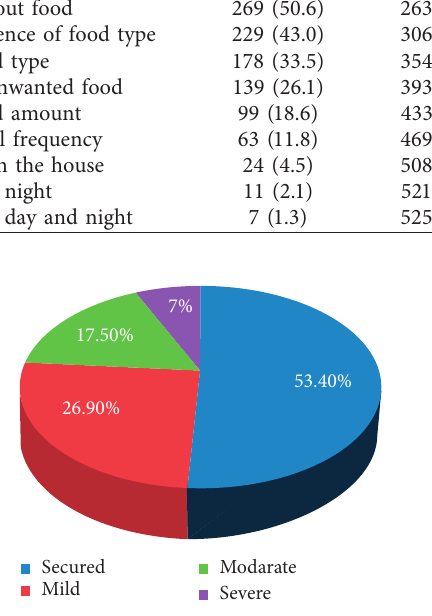
Figure 1: Household food security level of lactating women ( N � 532) in Moyale District, Borana, Southern Ethiopia,